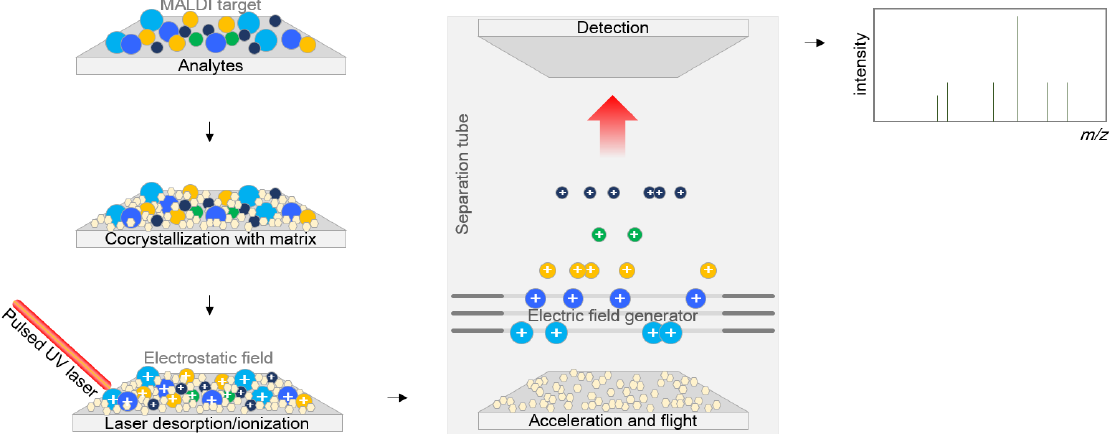
Figure 1. Mechanism of matrix-assisted laser desorption/ionization time-of-flight mass spectrometry. Analytes are first cocrystallized within the matrix, and energy is beamed down through a laser beam to ionize the analyte to generate separate protonated ions. These ions are accelerated at a fixed potential and separated from each other on the basis of their weights when they fly along the separation tube. The flight time of each ion is measured at the detection panel placed at the end of the flight tube.